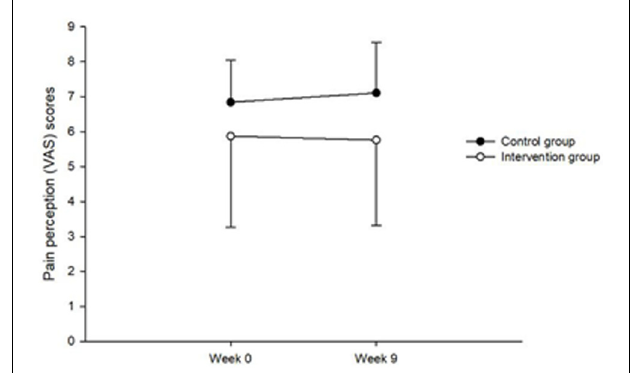
FIGURE 1 | Showing the Time × Group interaction for pain perception.